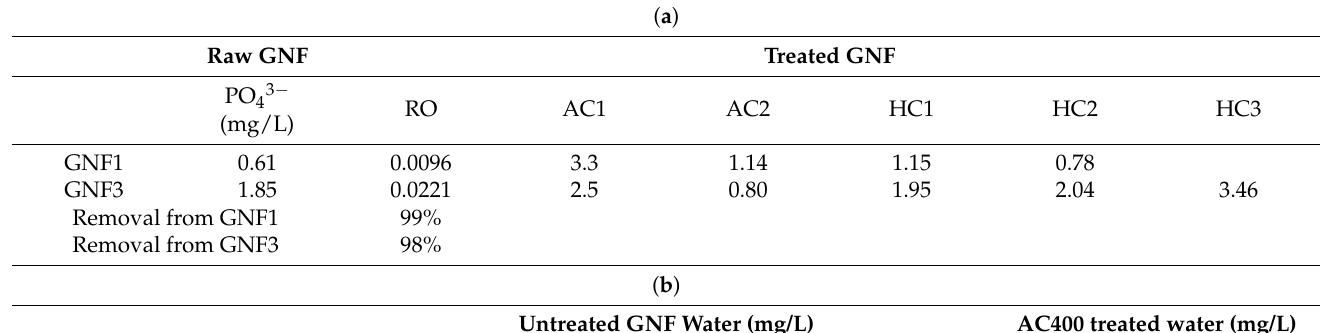
Table 9. ( a ) Reactive phosphate (PO 43− ) mg/L in GNF and treated GNF using HCs and ACs. ( b ) Results of nutrients removal by AC400 and RO from GNF1 and GNF3.